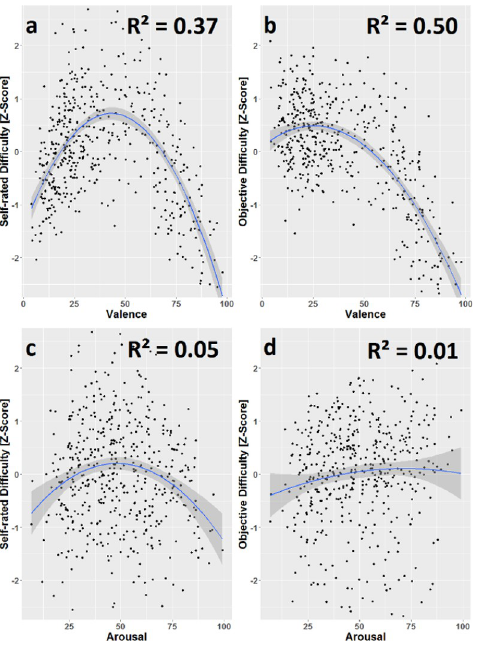
Fig 1. Plots visualizing the relationship of valence and arousal with both difficulty measures. Data points are averages over videos. The ribbon depicts the 95% confidence interval. A clear negative curvilinear relationship can be seen between valence and SRD (a). A similar relationship exists for valence and OD (b), although, the curve is less symmetrical with the high valence region featuring the lowest OD values. For the arousal measure the data does not exhibit such a visually clear relationship with the OD or SRD measure; this is also indicated by the low adjusted R 2 values (c,d).